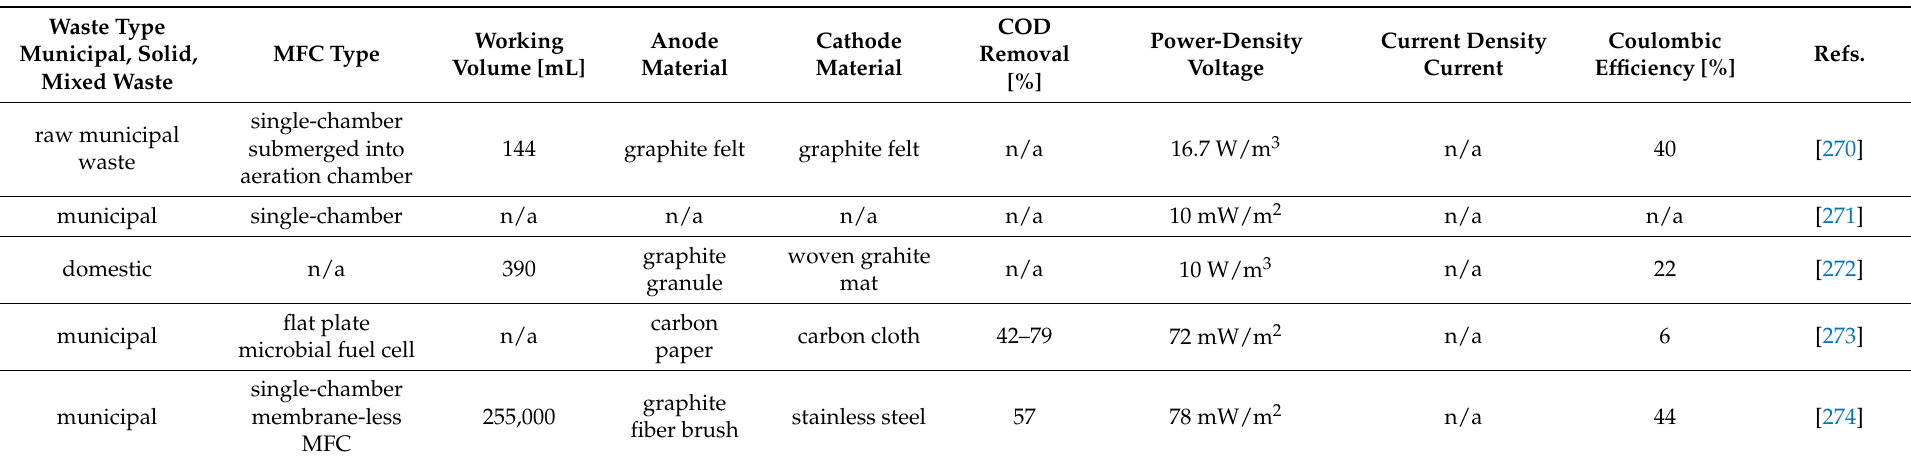
Table A11. Summary of studies reporting use of municipal, solid, and mixed waste in